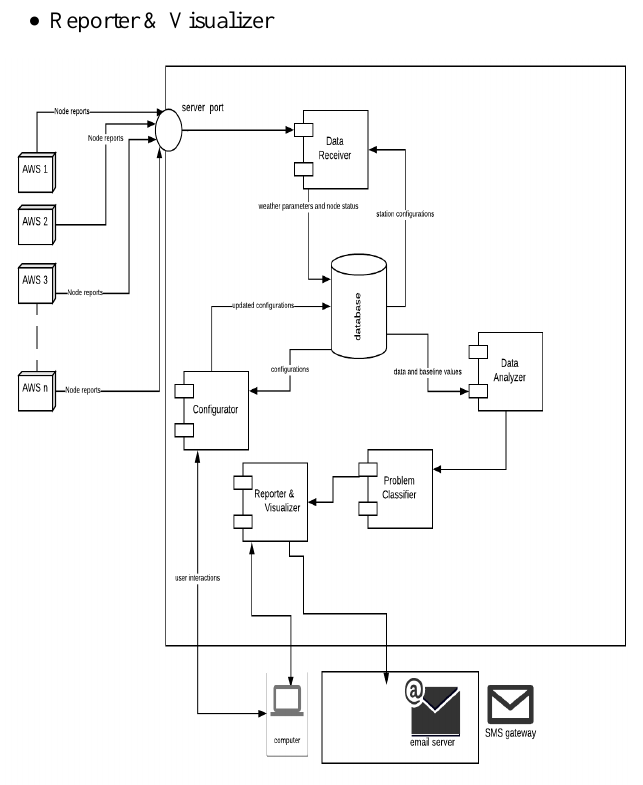
Figure 1 . Architecture of AWS Condition Monitor running at the server